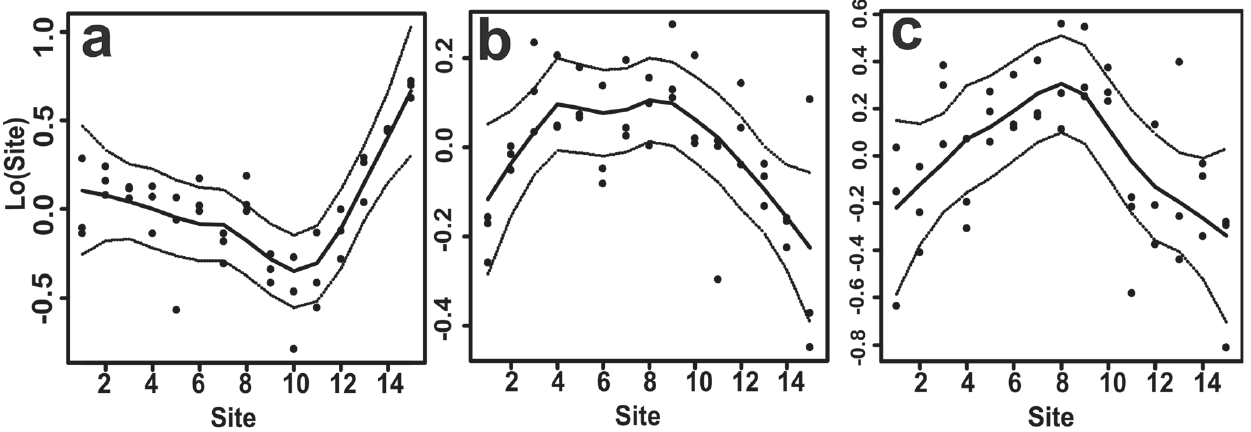
Fig. 3. GAM results for May and August of site influence on fish density to show differential distribution of species in Lake Chapala. a: Chirostoma jordani ; b: Chirostoma consocium ; c: Chirostoma labarcae . Circles represent the residuals. Spline fit (solid line) is bound by 95% confidence intervals (dotted lines).